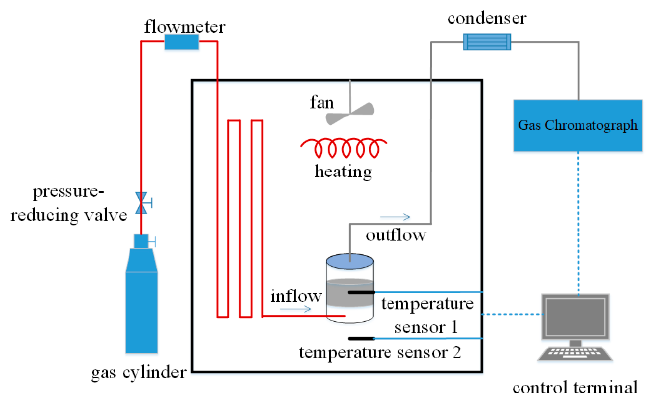
Figure 1. Coal oxidation and temperature rise experimental system.